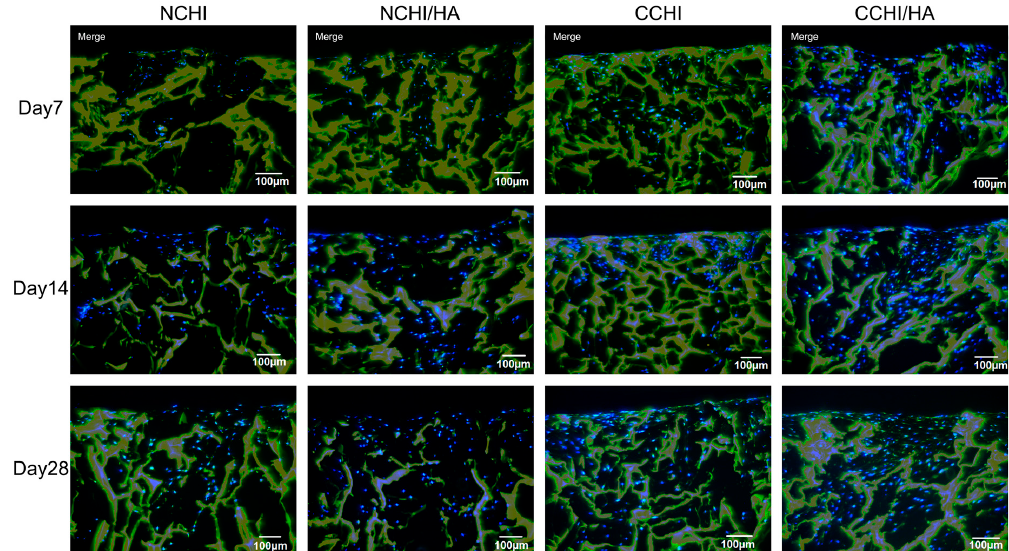
Figure 5. Immunofluorescence staining of aggrecan ( green ) at Day 7, 14, and 28 both in chitosan and chitosan with hyaluronic acid scaffolds with hADSCs cultured in normal (NCHI and NCHI/HA) or chondrogenic medium (CCHI, CCHI/HA). The chitosan and chitosan with hyaluronic acid scaffolds fluoresced yellow with living cell nuclei fluorescing blue . Magnification set at 10×.